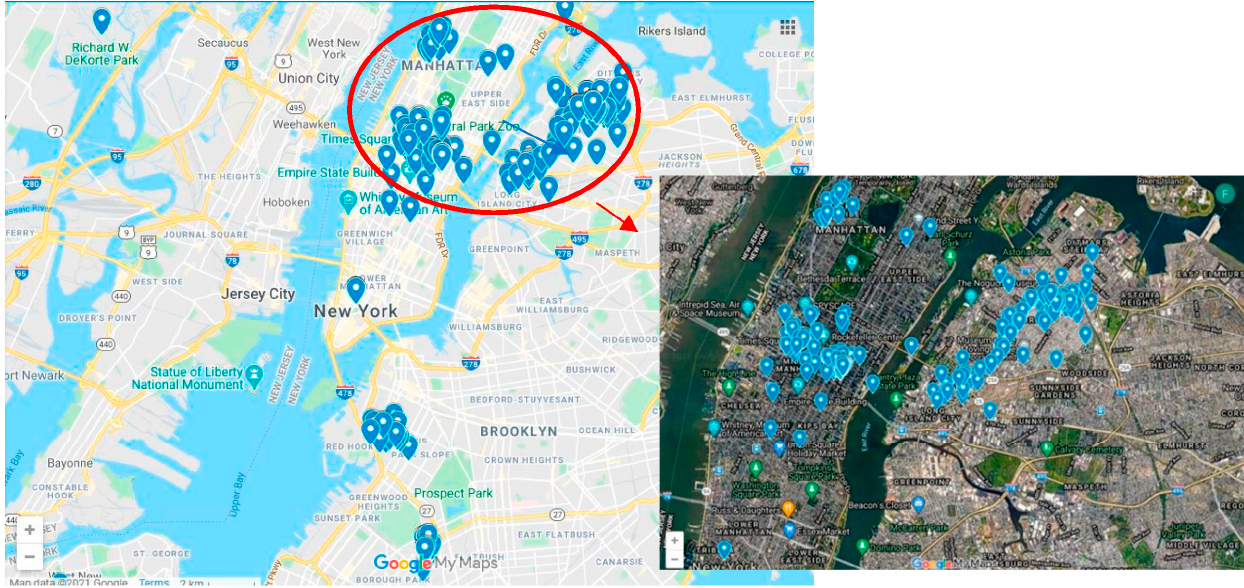
Figure 7. The sequence of registered check-ins for the user with ID 84 in the Foursquare dataset. To compare the efficacy of the temporal and geographical CI of check-in data in location prediction for LBSN users, we designed four sets of experiments obtained by changing the attention gates in our proposed architecture’s recurrent layer. We used the recall metric (Rec@k, k = 5, 10) to evaluate the above-mentioned methods’